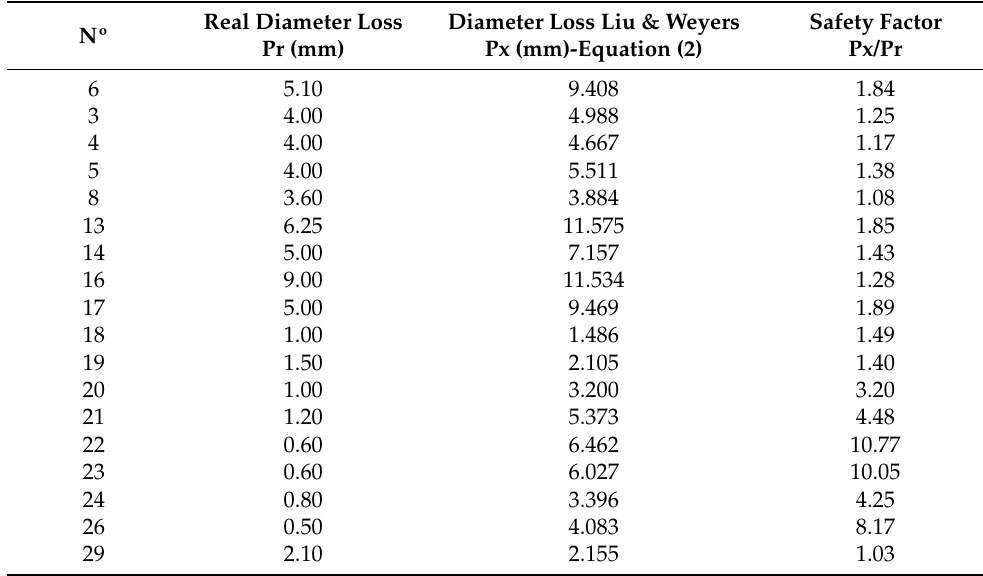
Table 6. Case studies with favourable results using the Vu and Stewart (1998)